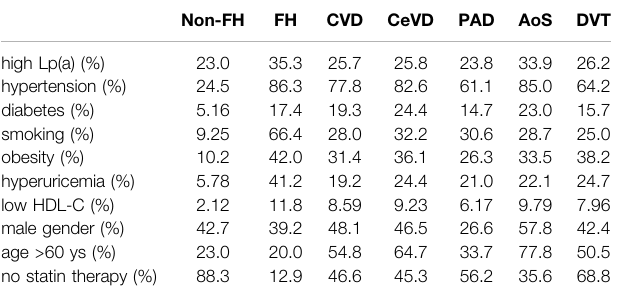
TABLE 2| Prevalenceofcardiovascularriskfactorsinthewholestudypopulation, in various atherosclerotic vascular diseases and in deep vein thrombosis. Non-FH